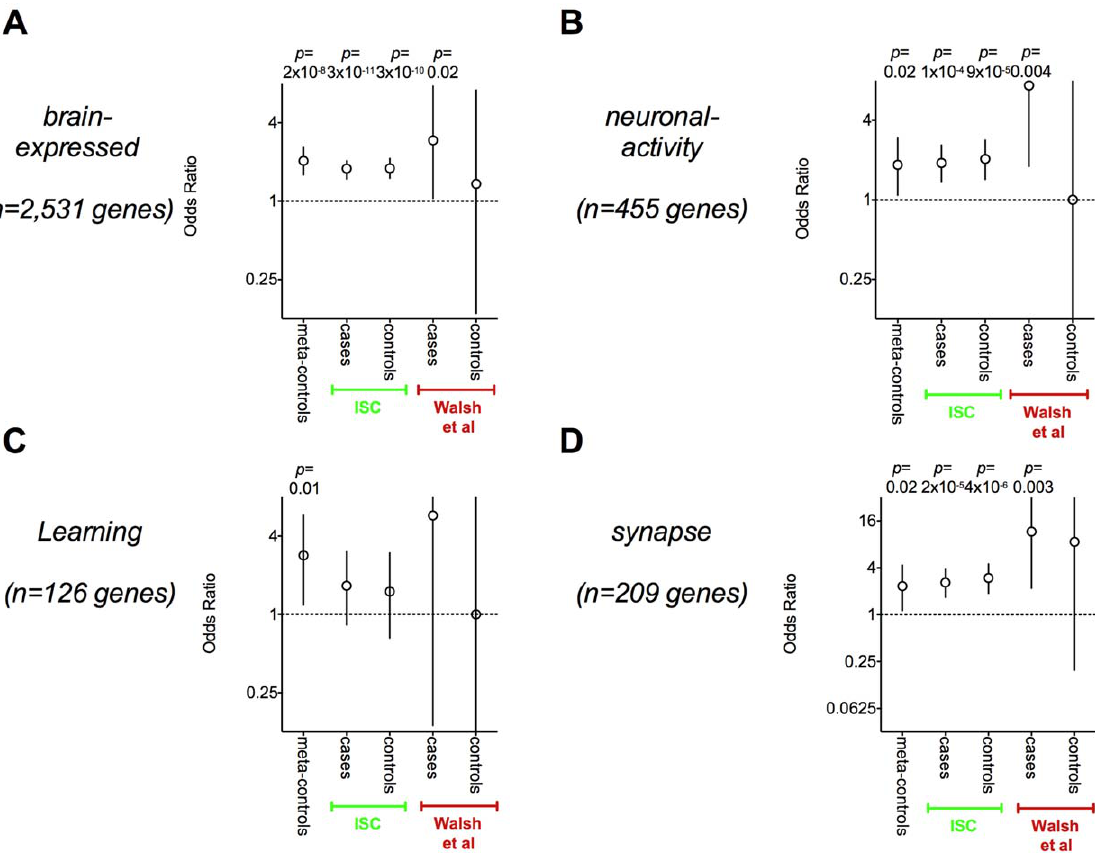
Figure 2. Neurodevelopmental gene sets are enriched in CNVs for affected and unaffected individuals. Here we present results from three gene sets – neuronal-activity genes ( A ), brain-expressed genes ( B ), learning genes ( C ), and synapse genes ( D ). For each set we calculate enrichment among genes disrupted by rare CNVs with a Fisher’s exact test in meta-controls and also within the affected and unaffected individuals in the Walsh et al. study and the ISC study. We explicitly list all p -values , 0.1. Each point represents an odds ratio and is plotted with a 95% confidence interval. A comparable degree of enrichment was observed across all data sets for each of the gene sets.